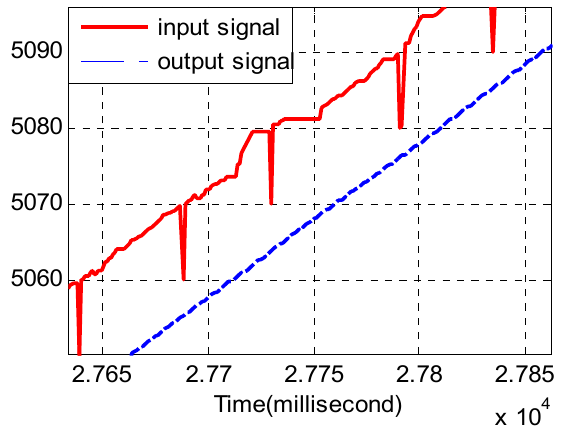
Figure 12. Partial enlarged drawing of Figure 11.